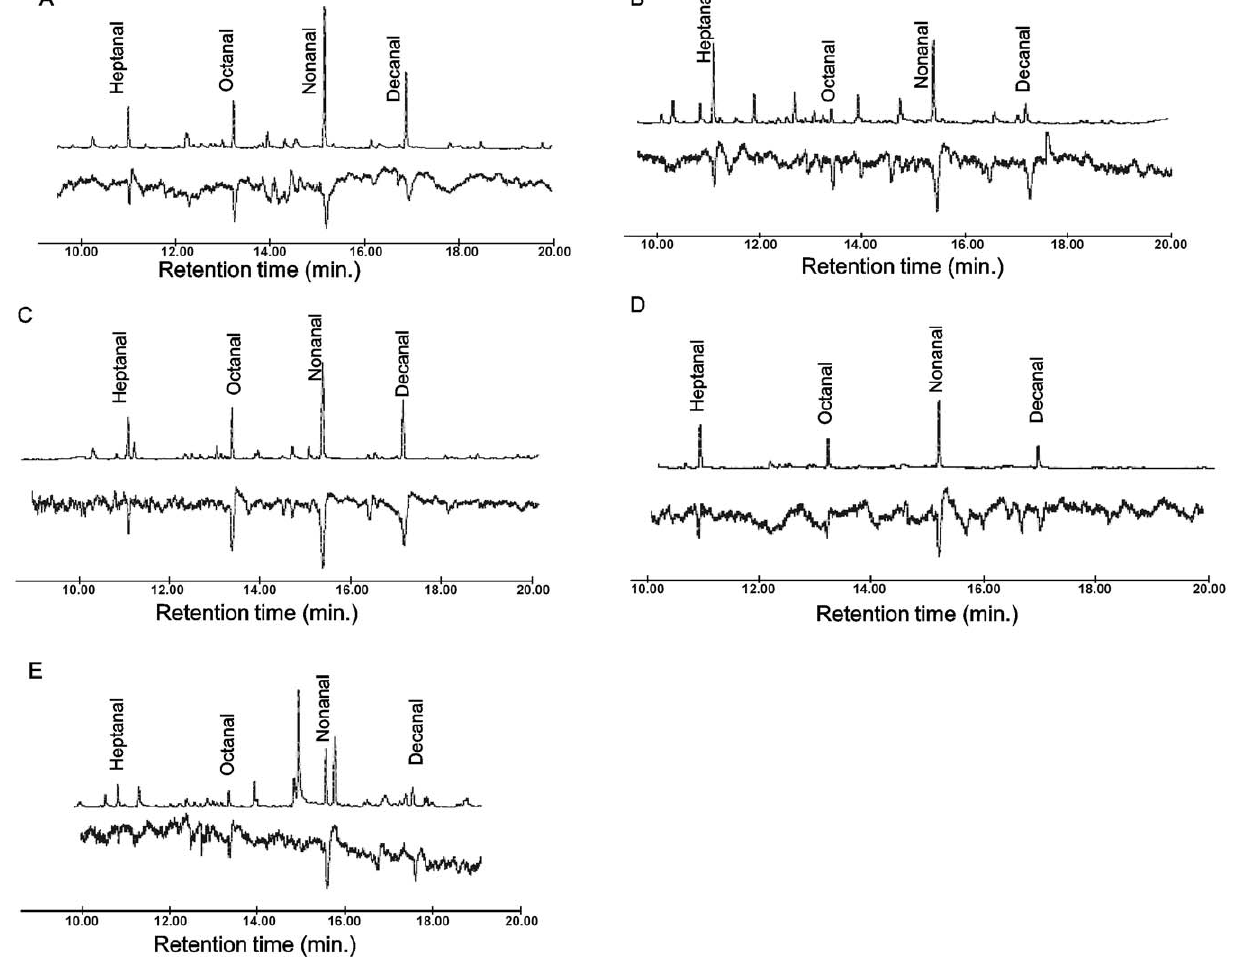
Figure 4. Representative GC-EAD profiles using wild caught adult female Ae.mcintoshi to the different host odors. (A) Cow (B) Donkey (C) Human (D) Goat (E) Sheep. Upper traces are FID (chemical profile) of the respective host odor and lower traces are EAD responses. Regardless of host type, similar responses to the four aldehydes (whose peaks are labeled in the uppermost trace) were reproducibly recorded not only in this species but in Ae. ochraceus and diverse species of Culex and Mansonia which are secondary RVFV vectors (n=3). (Scale bar in all the GC-EAD runs, 1 mV.)